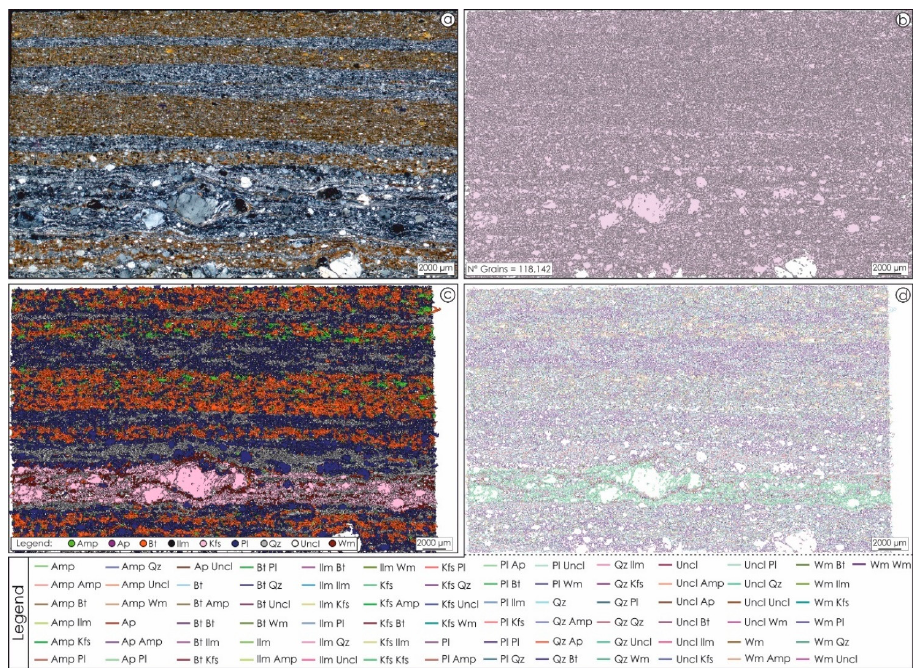
Figure 8. Mylonitic paragneiss outputs of the Micro-Fabric Analyzer: ( a ) the thin section optical image (38.6 × 23.0 mm 2 in size with a pixel size of 5.29 μ m); ( b ) output of the GSD tool; ( c ) output of the Min-GSD tool; ( d ) map of couples of mineral contacts. Mineral abbreviations from [46]. Uncl = Unclassified phase. ISPRS Int. J. Geo-Inf. 2021 , 10 , x FOR PEER REVIEW